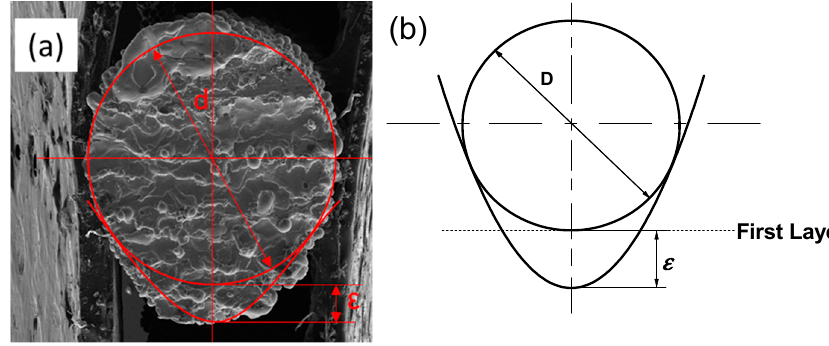
Figure 14. ( a ) Cross section of rod unit. ( b ) Geometric model of cross section.